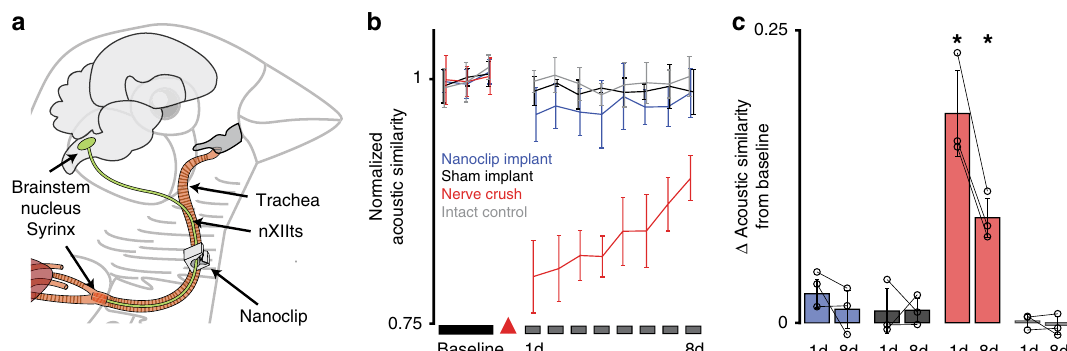
Fig. 2 Nanoclip nerve interface chronic implantation and functional safety. a Diagram of the nanoclip interface implanted on the nXIIts nerve of the zebra fi nch. b Functional assessment of nXIIts following bilateral nanoclip implant (blue), sham implant (black), nerve crush (red), or intact (gray) quanti fi ed as the acoustic similarity of baseline to post-manipulation song structure (see “ Methods ” ). Line and error bars denote mean ± Std across n = 3 birds per condition. Red triangle marks day of surgery. c Summary statistics showing the difference in acoustic similarity between baseline song and songs produced on days 1 and 8 post manipulation. Colors denote experimental conditions as in ( b ). Each data point represents the mean across all motifs from a single bird. Bars and error bars denote mean ± Std across n = 3 birds per condition. Two-tailed paired t -test, day 1: P = 0.02; day 8: P = 0.016. * P < 0.05. Source data are provided as a Source